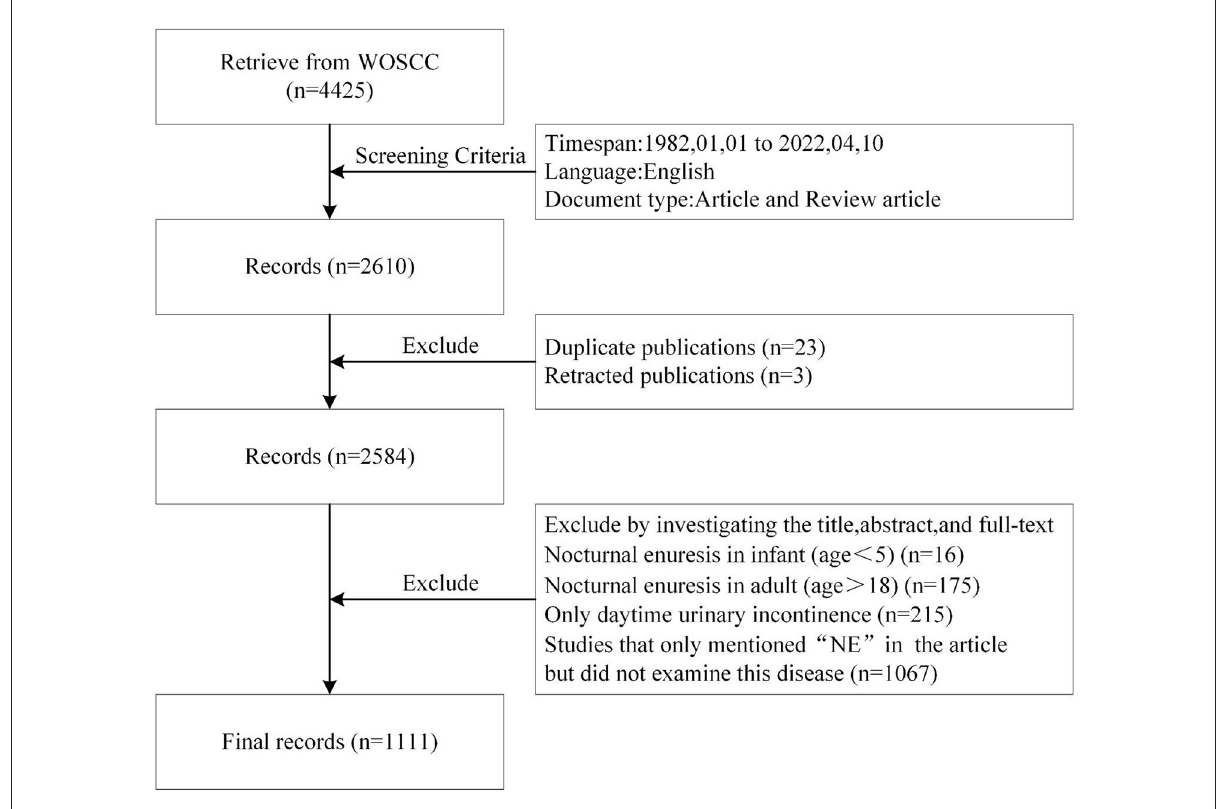
FIGURE1 Flowchart depicting the article selection